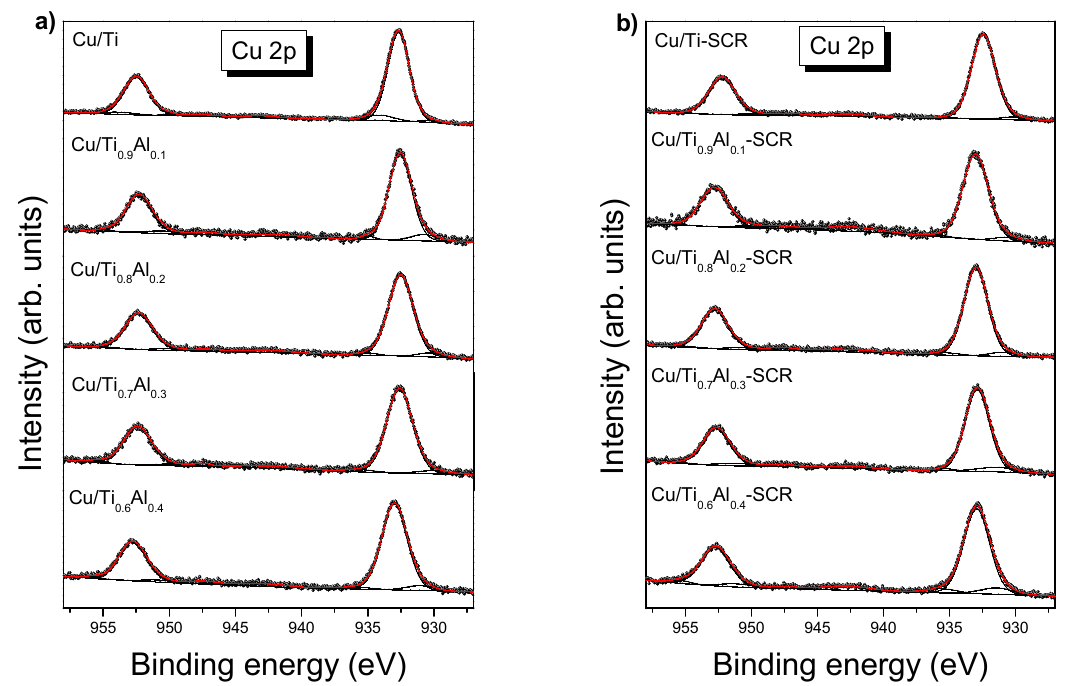
Figure 6. Cu 2p XPS spectra of fresh ( a ) and used ( b ) catalysts. which can be assigned to lower valence Cu (Cu 0 at BE of Cu 2p 3/2 < 931.4 eV and Cu + at 932.5–933.0 eV) and to Cu 2+ species (~935.0 eV). The most dominating component (>90% of total spectrum area) attributed to Cu ions in Cu-O-Ti sites with a binding energy